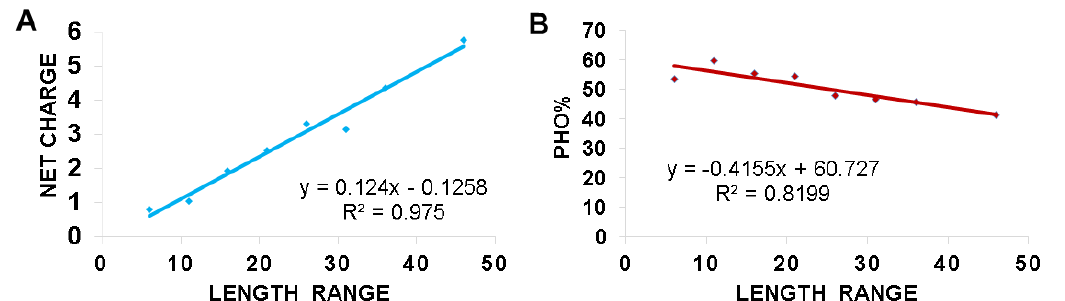
Figure 5. Relationships between peptide length and averaged net charge ( A ); and total hydrophobic content ( B ) based on the data in the APD. The 1015 frog antimicrobial peptides in the APD were split into various groups at a length step size of 5: 6–10, 11–15, 16–20, 21–25, 26–30, 31–35, 36–40, 41–45, and 46–50 amino acids. The number of peptides in each group varies from 10 to 325. The length group 41–45 was not included in this plot due to a small number of only four members and the existence of the only two frog defensins. Data from the APD as of June 2020 [78].